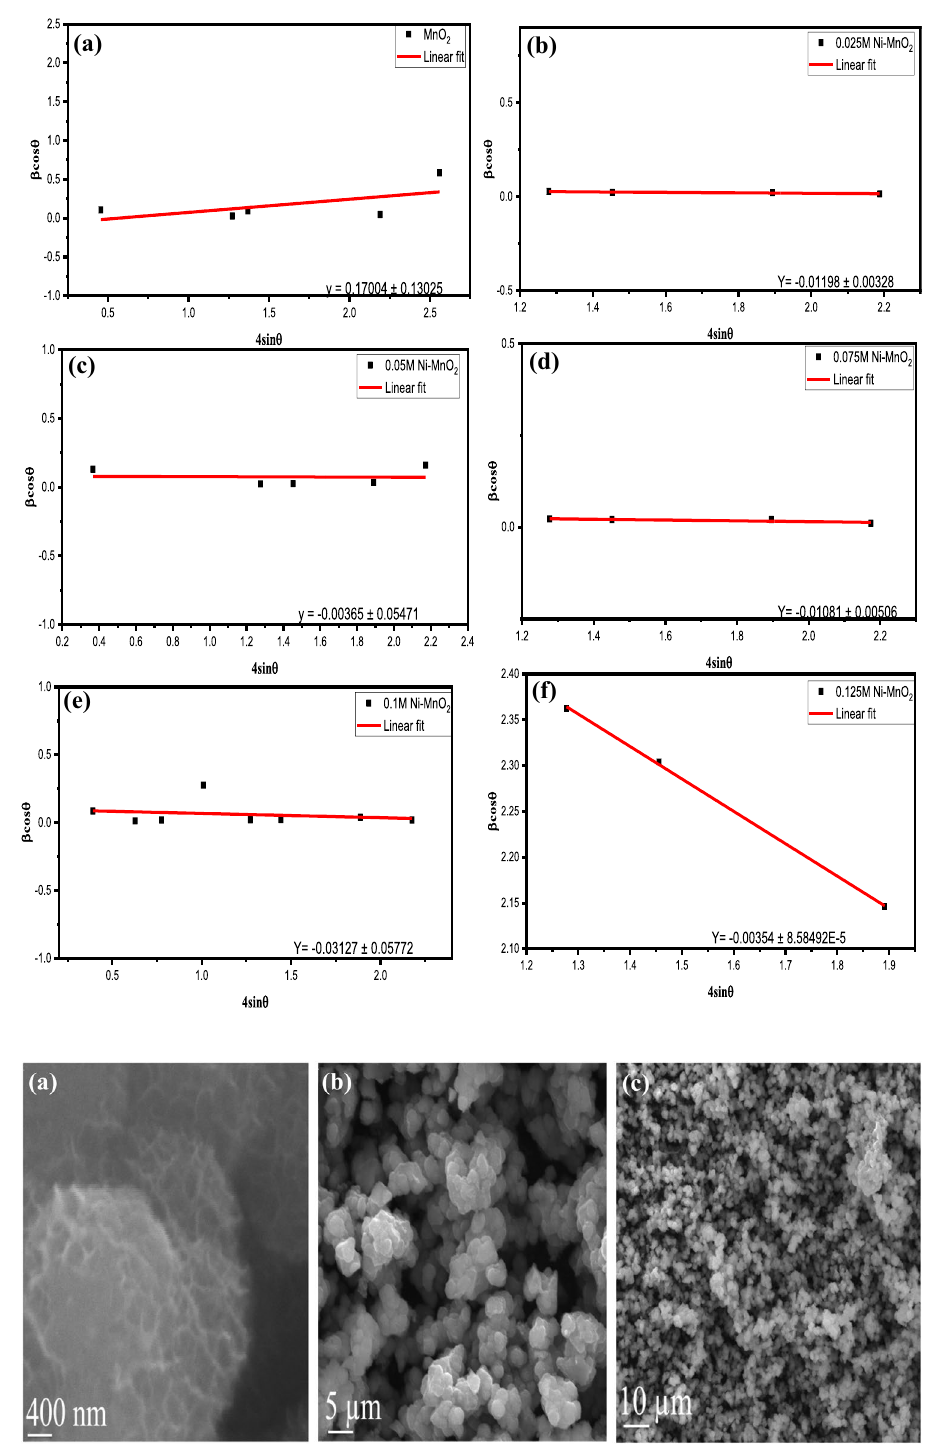
Fig. 3 Williamson Hall plots of ( a ) pure MnO , ( b ) 0.025 M 2 Ni-MnO , ( c ) 0.05 M Ni-MnO , 2 2 ( d ) 0.075 M Ni-MnO , ( e ) 0.1 M 2 Ni-MnO , and ( f ) 0.125 M Ni- 2 MnO